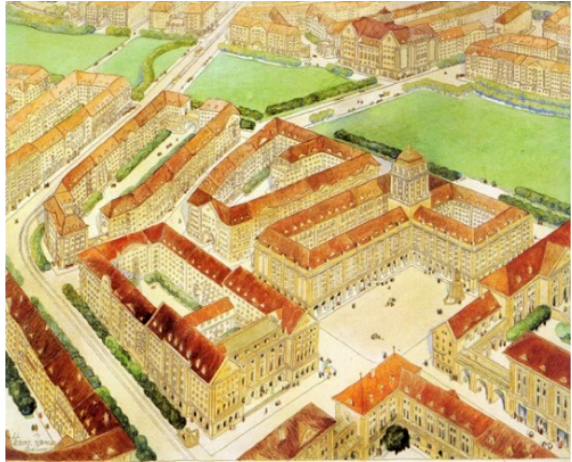
Figure 2. 1910 Greater Berlin competition, H. Jansen. Aerial view of proposed development, Tempelhofer Feld. Source: Tubbesing